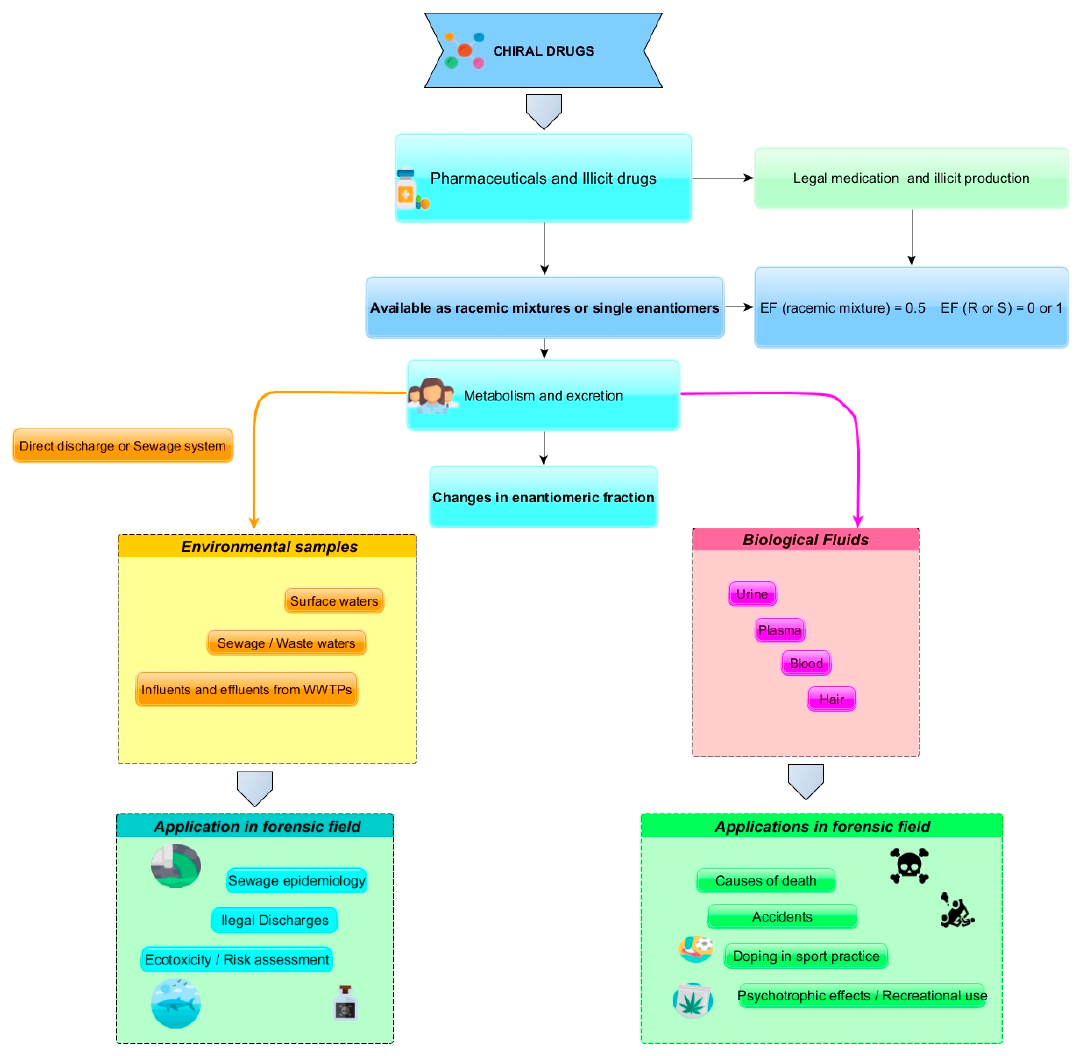
Figure 1. Application of chiral drug analysis in forensic chemistry.